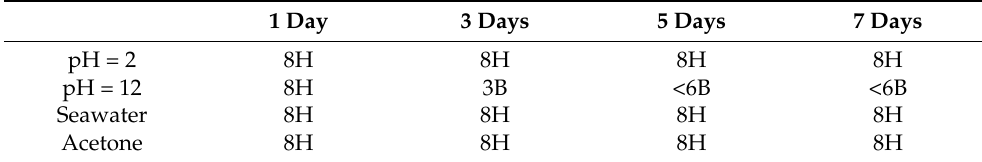
Table 4. The pencil hardness grade of MXDA-OSER being soaked in different solutions.